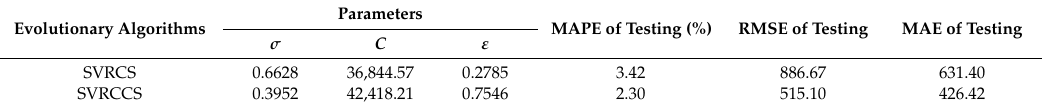
Table 5. Three parameters of SVRCS and SVRCCS models for Example